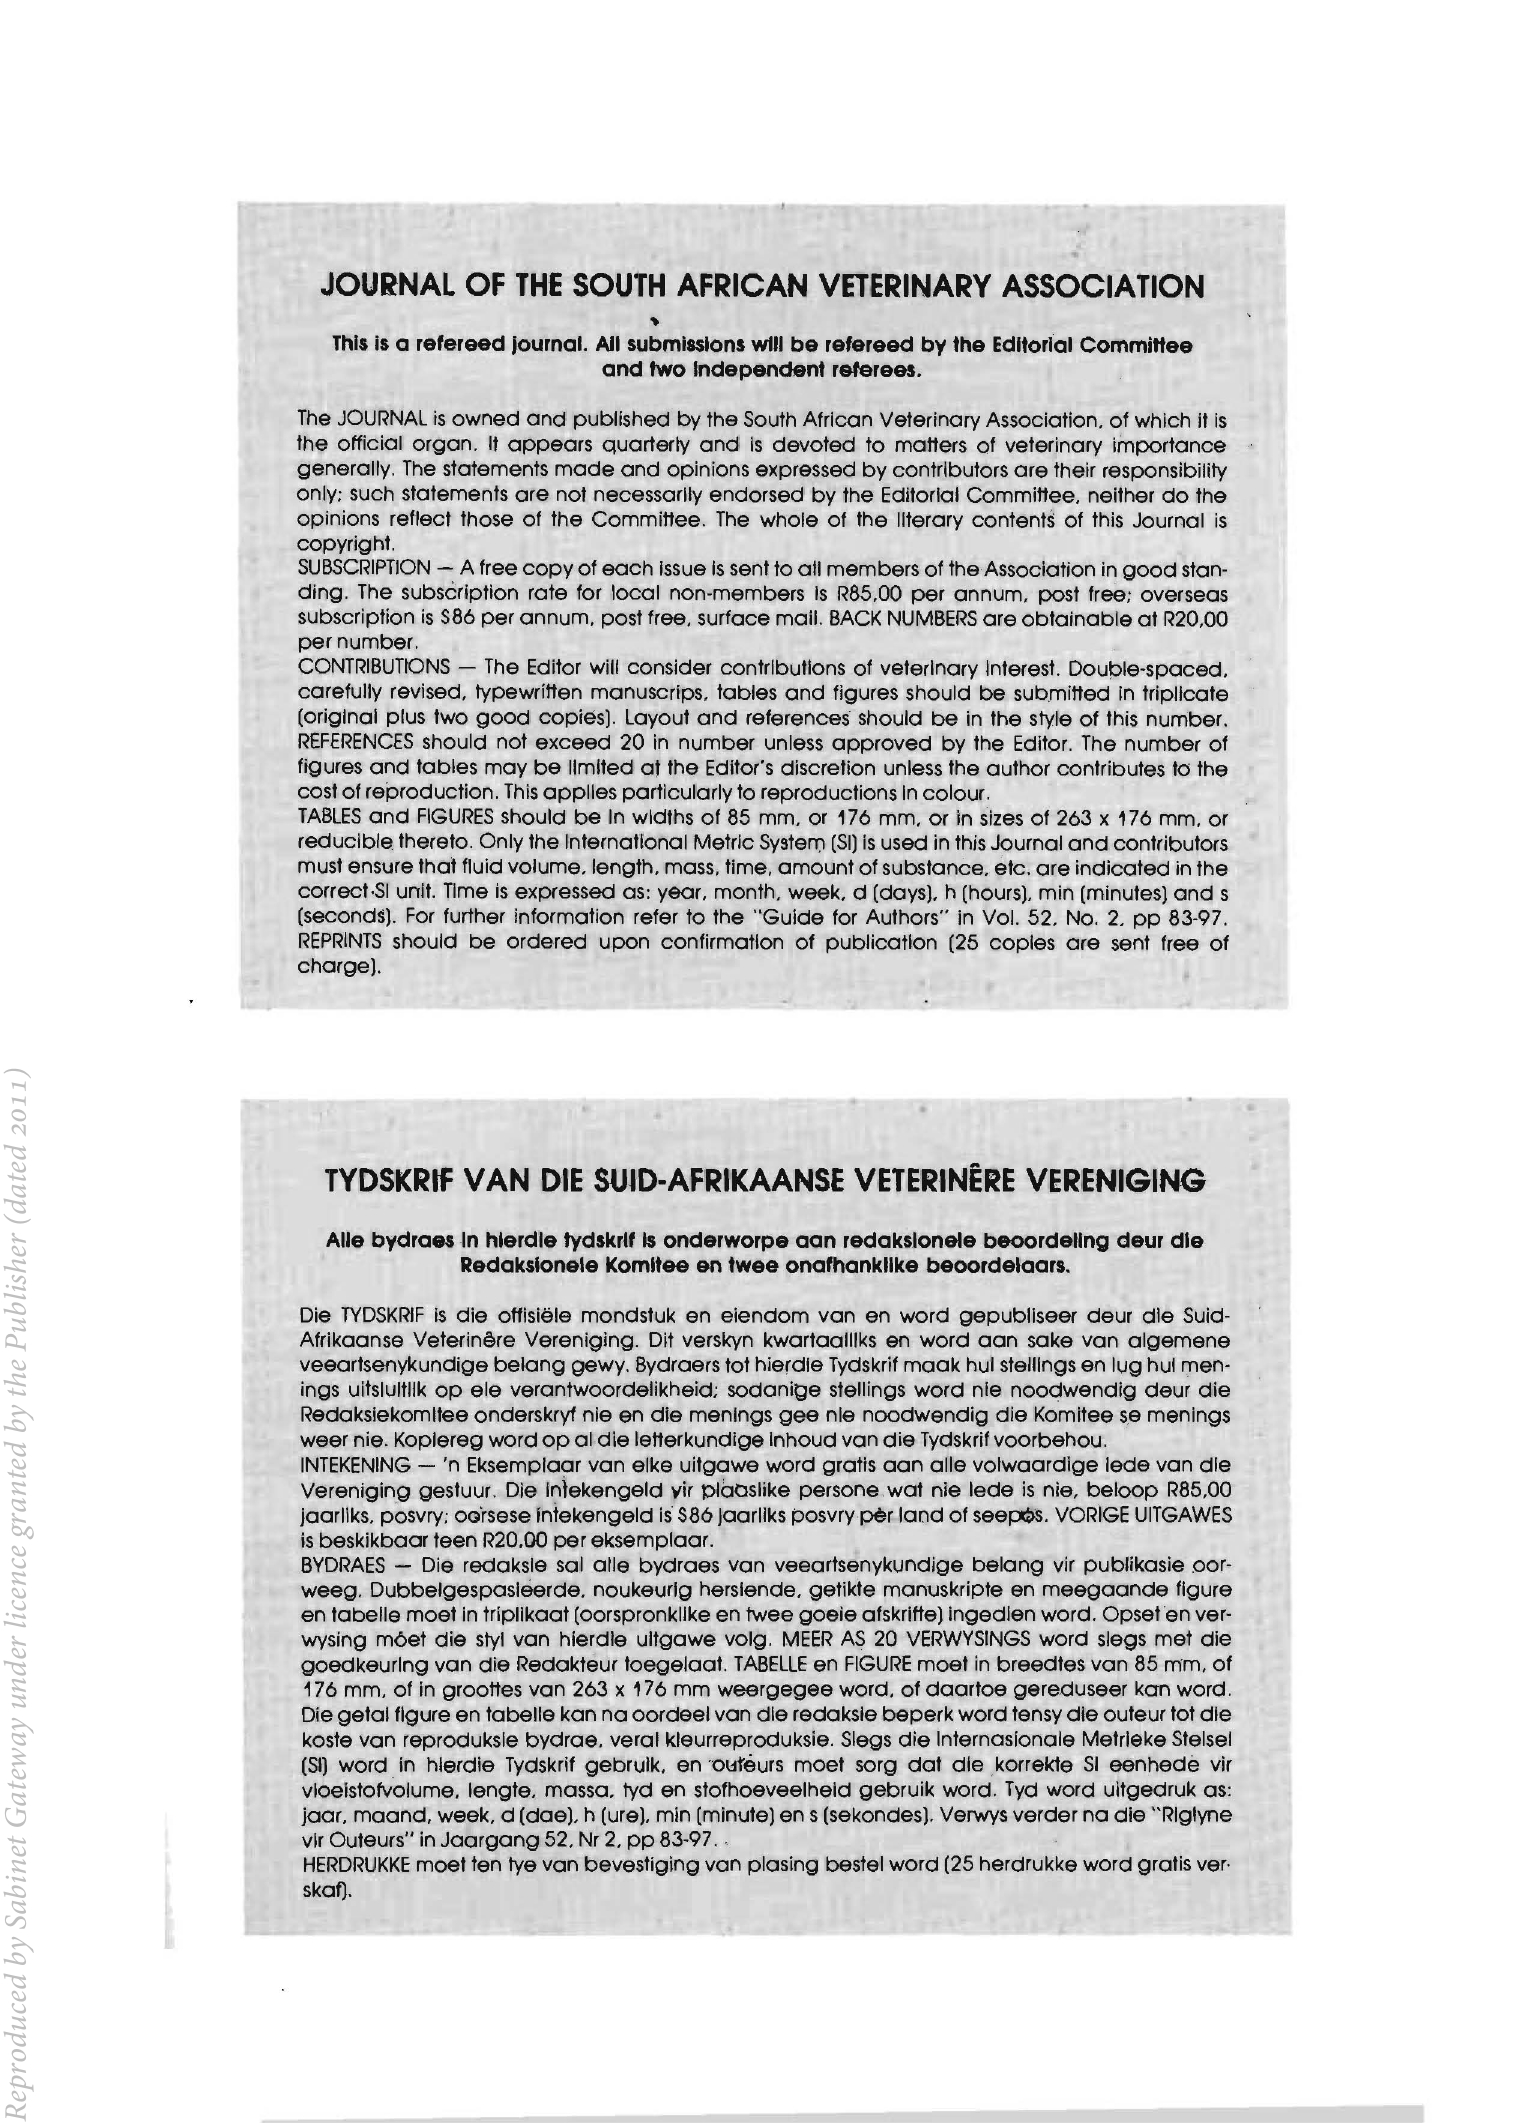
goedkeurlng van die Redakteur toegelaat. TABELLE en FIGURE moet in breedtes van 85 mm. of 176 mm. of in groottes van 263 x 176 mm weergegee word. of daartoe gereduseer kon word. Die getal figure en tabelle kan na oordeel van die redaksle beperk word tensy die outeur tot die koste van reproduksle bydrae. veral kleurreproduksie. Slegs die Internaslonale Metrleke